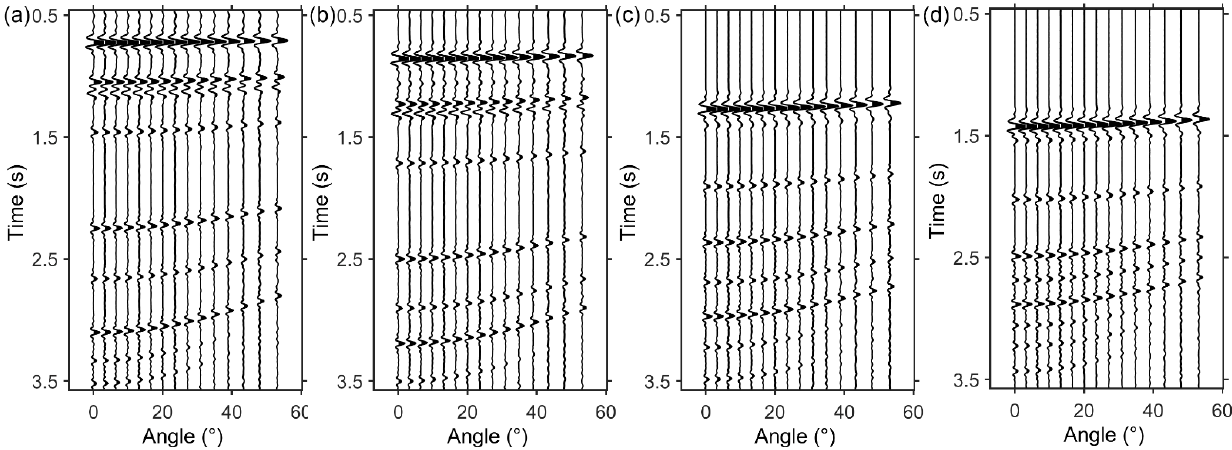
Figure 5. The noise-free seismic angle gathers at ( a ) 1.25 km, ( b ) 2.25 km, ( c ) 3.25 km, and ( d ) 4.25 km of the model.